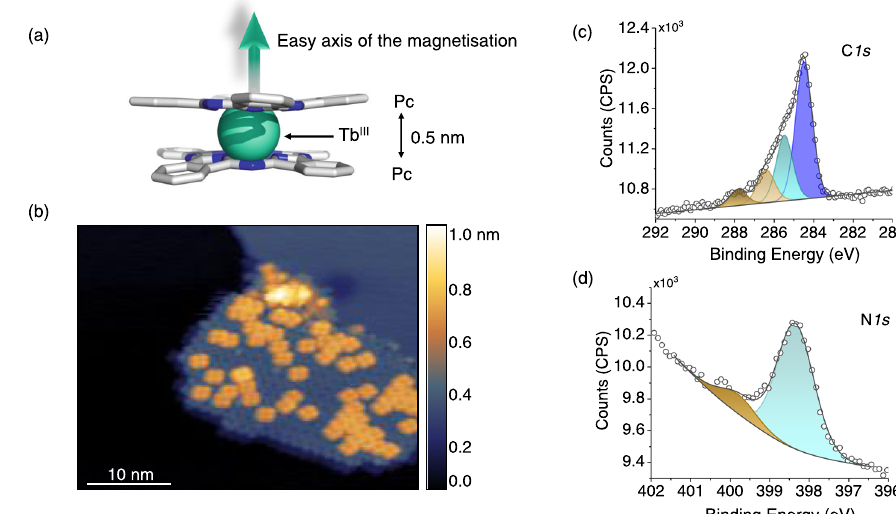
Fig. 1 Structural characterisation of the TbPc 2 sub-monolayer on Pb(111). a Scheme of the TbPc 2 structure. Colour code: grey, carbon; blue, nitrogen; light cyan, terbium; hydrogens are omitted for clarity. The easy axis of the magnetisation is directed perpendicularly to the phthalocyanine (Pc) planes and sketched by an arrow. b STM image of a TbPc 2 island on Pb(111) recorded at 35 K (I tunnel = 5 pA, V bias = 2 V). The Z-colour scale is shown on the right. c C 1s and d N 1s XPS core-level spectra of the TbPc 2 sub-monolayer on Pb(111). Main components are shown in blue or cyan; shake-up components are shown in